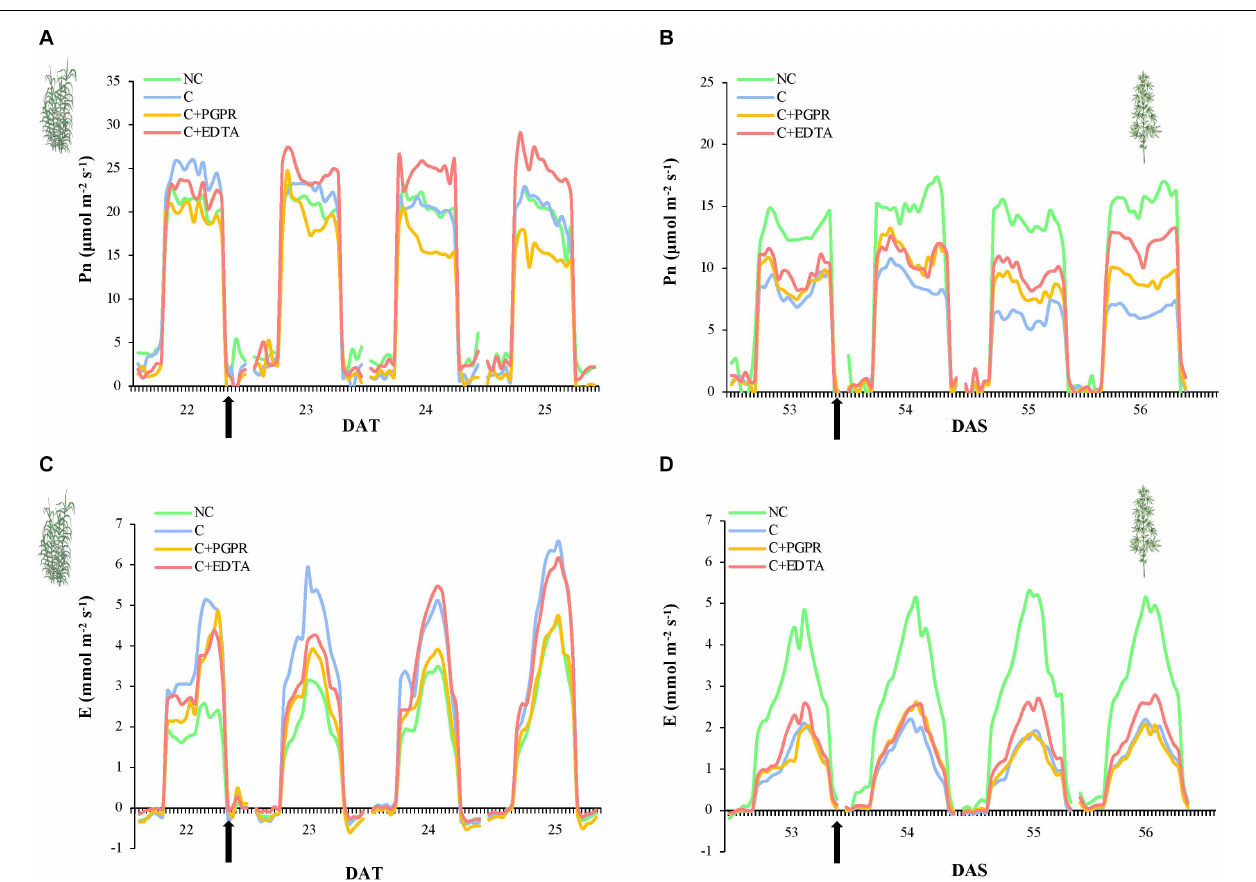
FIGURE 3 | Whole-canopy net photosynthetic rate (Pn, µ mol m − 2 s − 1 ) and transpiration rate (E, mmol m − 2 s − 1 ) of giant reed (A) and hemp (B) as affected by PGRP and EDTA application (black arrows). DAT, day after transplanting.